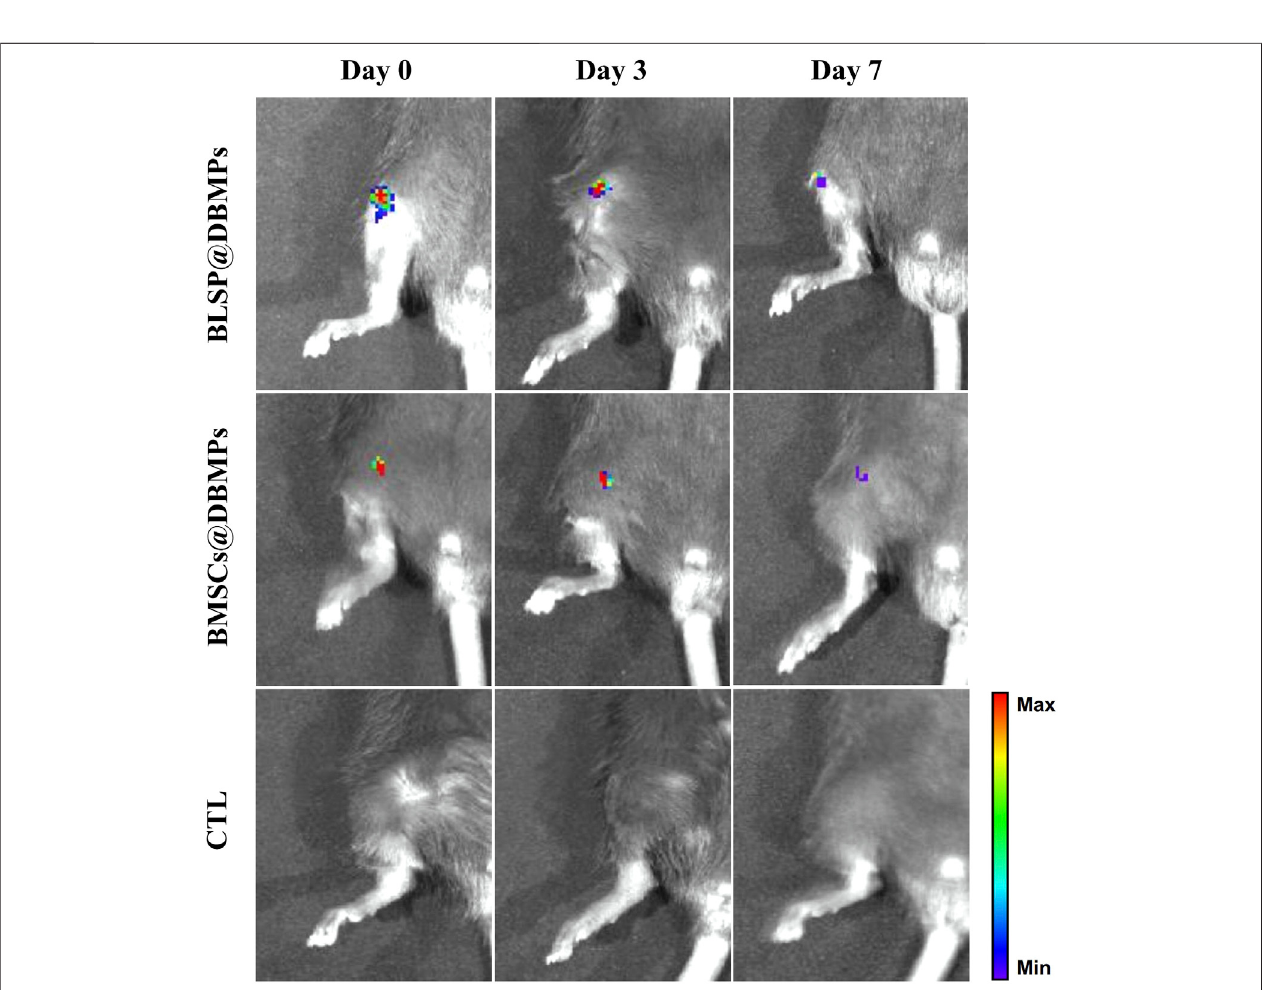
FIGURE5| Grossmorphologyand IVIS analysisshowedsimilar Dilintensitywhich wasdetected at thedistal femur intheBMSCs@DBMP or BLSP@DBMPgroup and can last at least 7 days.